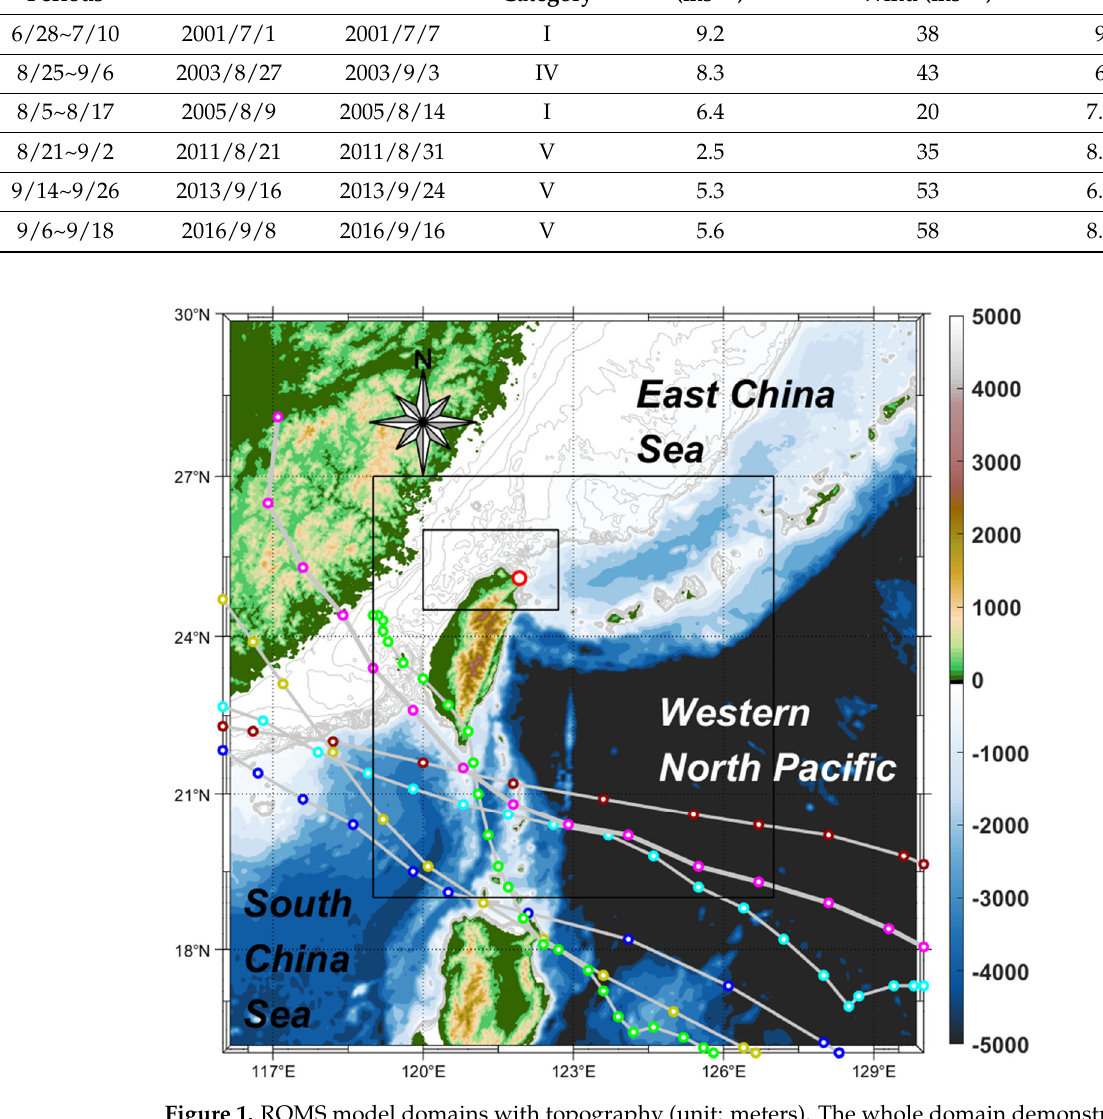
Figure 1. ROMS model domains with topography (unit: meters). The whole domain demonstrates the bathymetry surrounding main model domain. Small black box is the children domain with higher spatial resolution nested to parent domain (big black box). Typhoon tracks of 6 cases are shown in different color circles in 6-h intervals. Circles in brown, pink, cyan, blue, grass green, and green denote tracks of typhoons Dujuan, Meranti, Usagi, Utor, Sanvu, and Nanmadol, respectively. Big red circle denotes the location of Longdong buoy northeast of Taiwan.